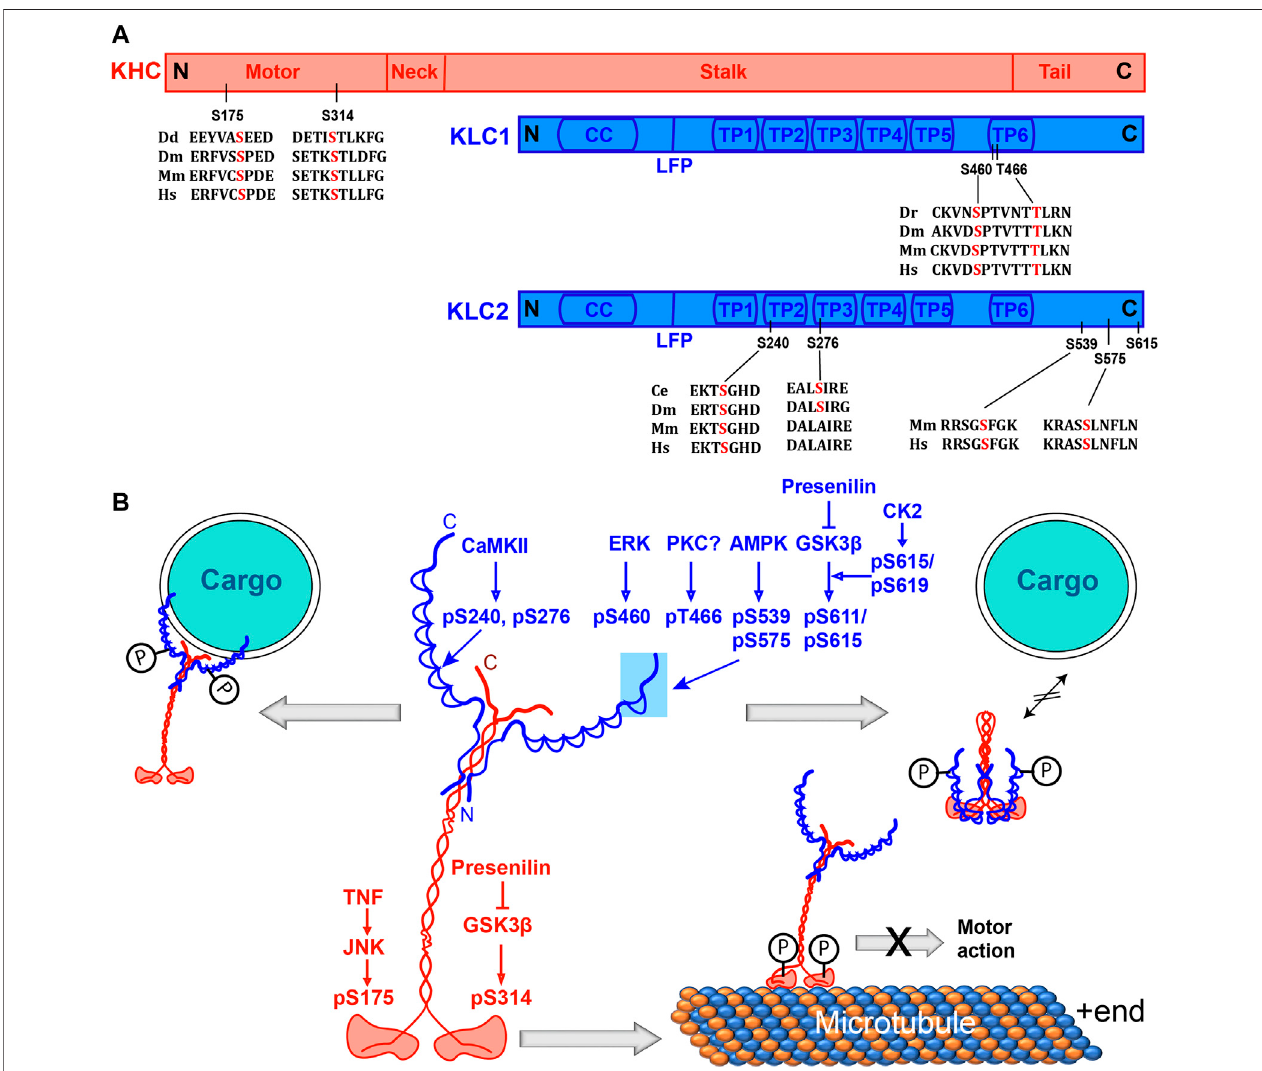
FIGURE1| PhosphorylationsitesonKinesin-1andtheireffectsonthemotor ’ sfunction. (A) DomainorganizationsofKHCandKLCsubunitswithrelativepositions of phosphorylation sites and alignments of the surrounding amino acid sequences from different species. Dd, Dr, Dm, Mm and Hs represent Dictyostelium , Zebra fi sh, Drosophila ,mice,andhumans. (B) SchematicsindicatethestructureoftheKinesin-1holoenzymeandillustratetheeffectsofphosphorylationofdifferentserineresidues. PhosphorylationoftheC-terminalpartofKLCbyERK,PKC,AMPKandGSK3 β ,respectively,disruptsmotor-cargointeractions.PhosphorylationattheN-terminal part of KLC by CaMKII recruits Kinesin-1 to GLR-1 vesicles and increases its transport. The GSK3 β and JNK – dependent phosphorylation at two different resides in the motor domain disrupts the motor activity. The phosphorylation by JNK was also shown to stabilize autoinhibited conformation. Abbreviations: AMPK, Adenosine Monophosphate-activatedproteinkinase; CC,Coiled coil,CK2,Casein Kinase2;cAMP,cyclicAdenosineMonoPhosphate;ERK, ExtracellularReceptorKinase;FEZ1, Fasciculation and elongation protein zeta 1; GSK3 β , Glycogen Synthase Kinase 3 β ; JIP, cJUN interacting Protein; KHC, Kinesin Heavy Chain; KLC, Kinesin Light Chain; LFP, Leucine Phenylalanine Proline motif; PKA, Protein Kinase A; PKC, Protein Kinase C; TP, Tetra-Trico-peptide repeat; S, serine; pS, phosphoserine.